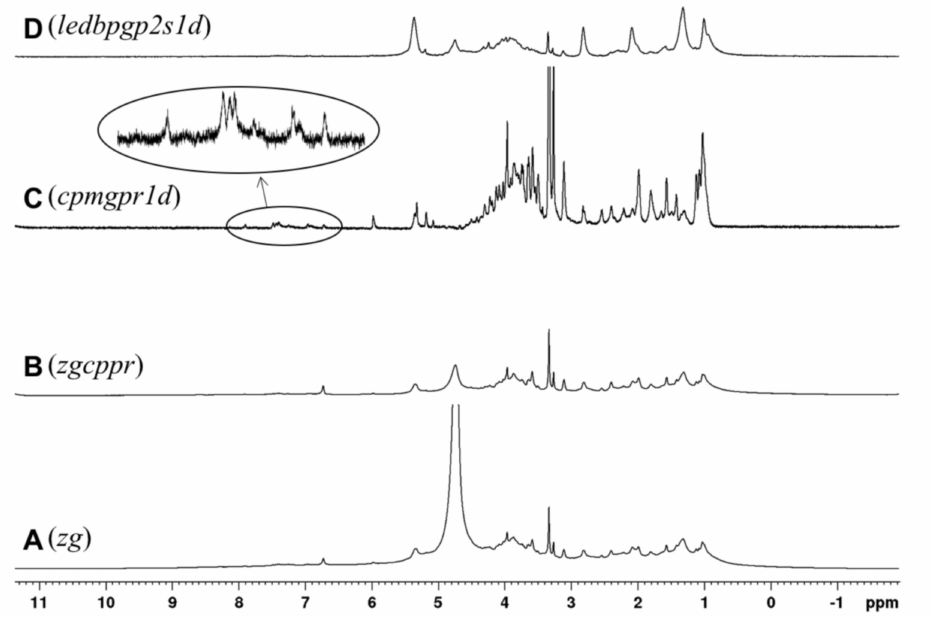
Figure 7. 1 H HRMAS NMR spectra of leaves derived from plants treated with high AA309 (=4.2 mg/kg N) dosage in D 2 O (MASr 12 kHz, 298 K), from bottom to top: ( A ) zg; ( B ) zgcppr; ( C ) cpmgpr1d; ( D )